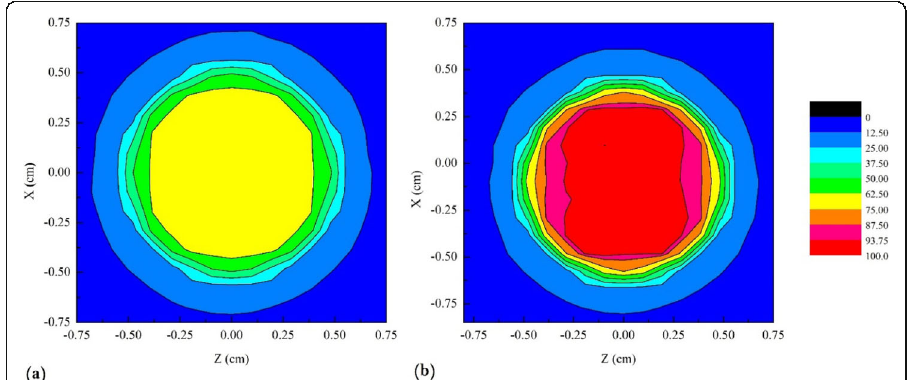
Fig. 7. The color-filled contour plots in the X-Z plane in the central depth of the tumor ( y = 0.45 cm) for a homogeneous and b heterogeneous models in the eye phantom including a tumor (the radius of the tumor area in the central depth is 0.5 cm) loaded with 100 nm GNPs of 30 mg/g. The color scale (in percent) has also been shown